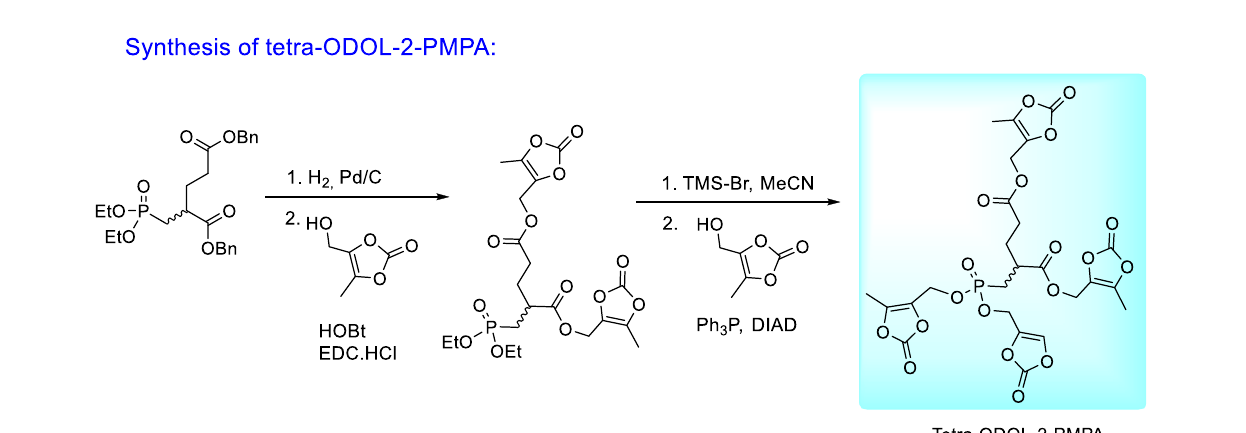
Frontiers in Chemistry |